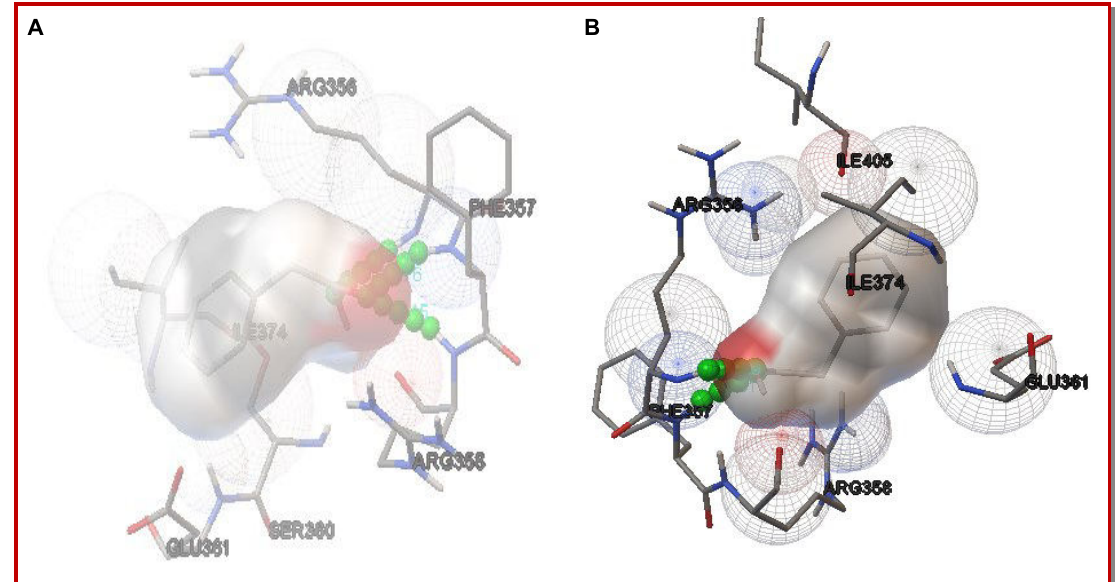
Figure 5: Inhibitory action of phenyl acetic acid with DPP-IV using AutoDock hydrogen bond interaction A) A chain B) B chain A